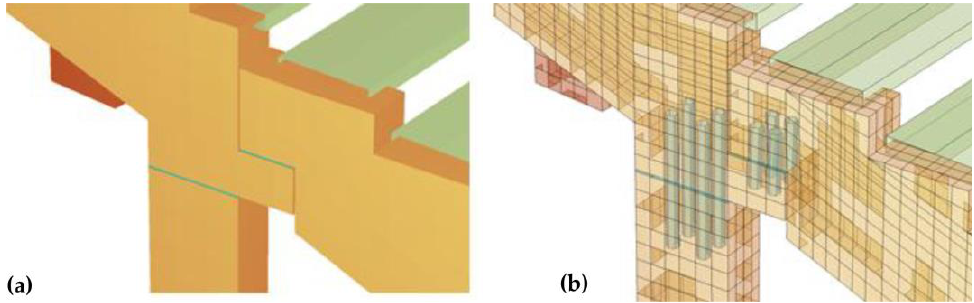
Figure 24. Detailed view of the stand's load-bearing beams: ( a ) support, ( b ) connection.